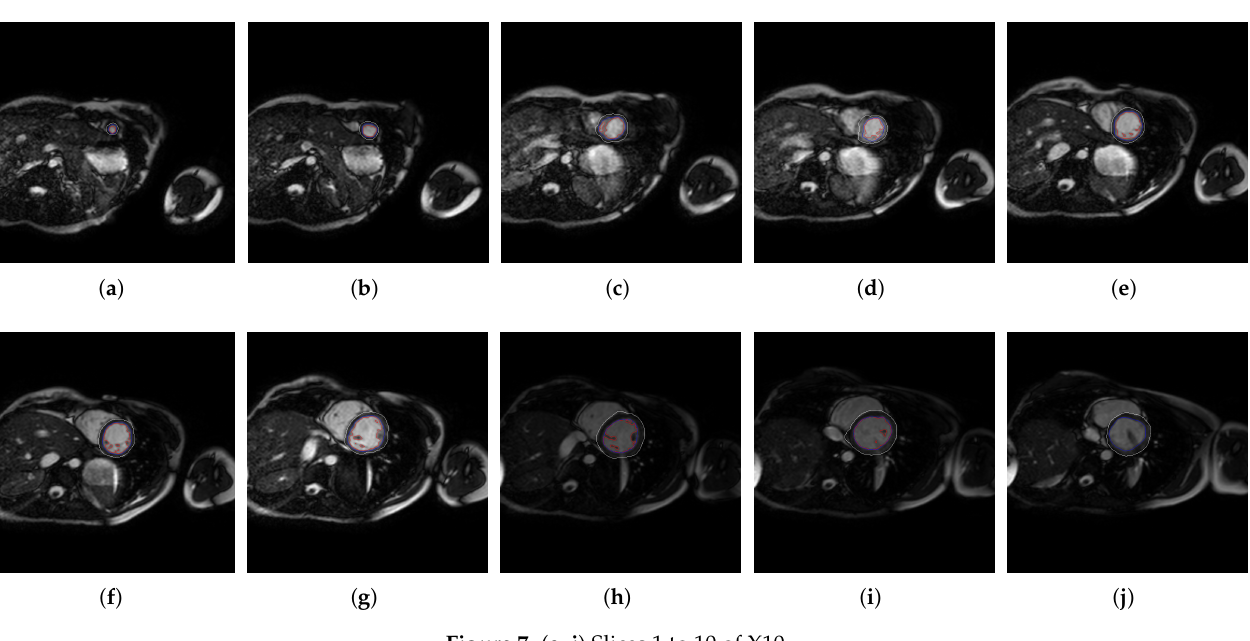
Figure 7. ( a – j ) Slices 1 to 10 of